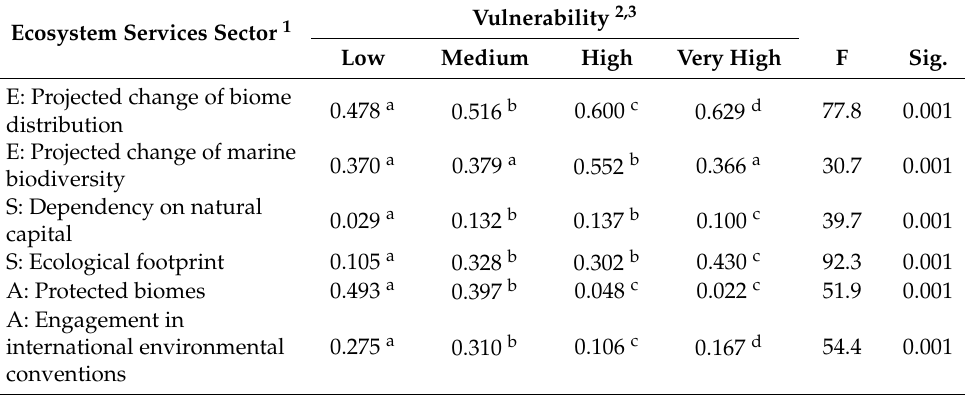
Table 7. Climate change vulnerability classes by ecosystem services sector vulnerability indicators. Vulnerability Ecosystem Services Sector 1